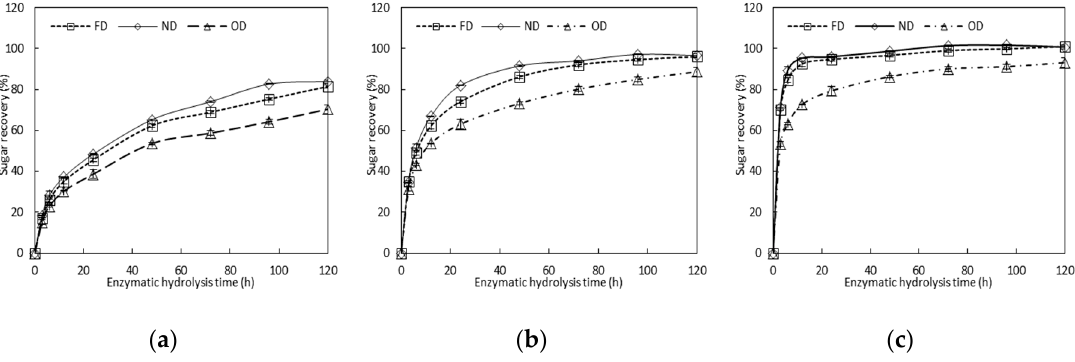
Figure 1. Enzymatic digestibility (sugar recovery) depending on the enzyme dosage of ( a ) 4 FPU/g biomass, ( b ) 10 FPU/g biomass, and ( c ) 20 FPU/g biomass.